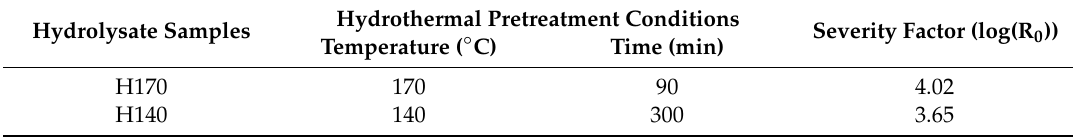
Table 1. Severity factor for the hydrolysates from HWE.